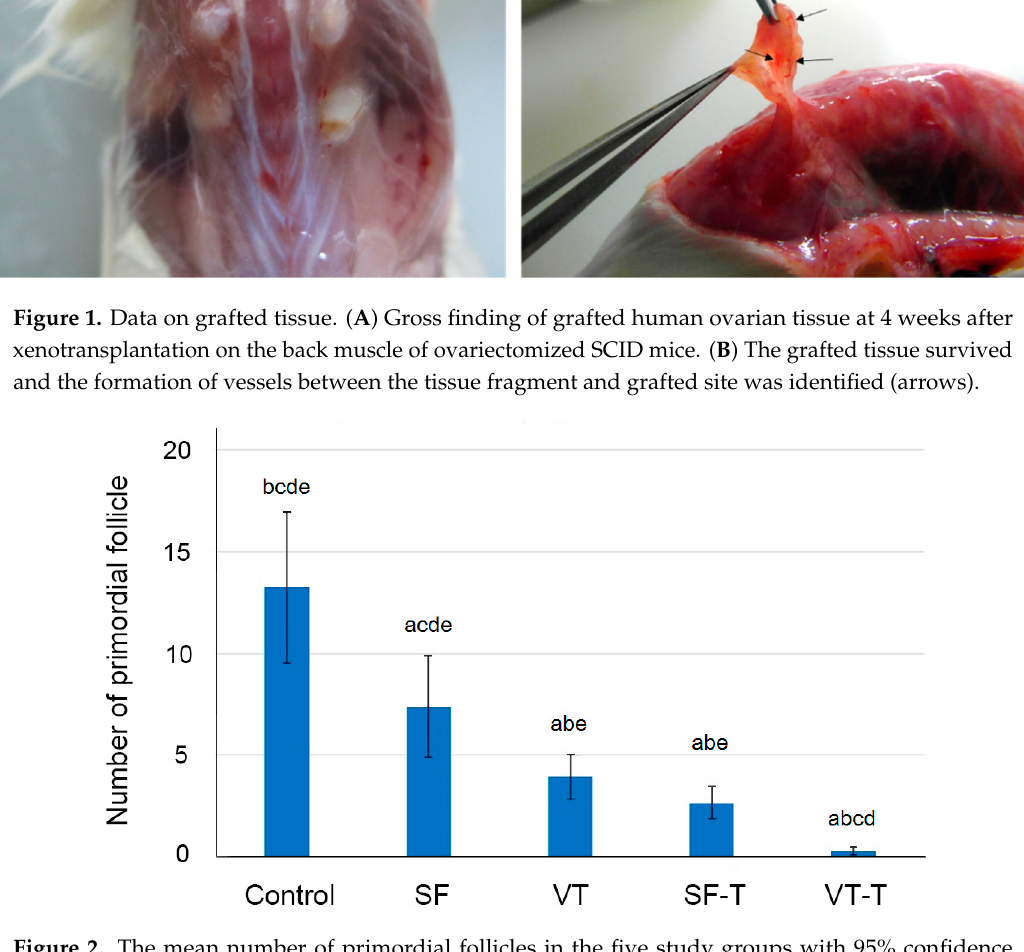
Figure 2. The mean number of primordial follicles in the five study groups with 95% confidence intervals. Student’s independent t -test showed that the mean number of follicular counts was significantly different among the different groups (letters above bars indicate the another groups statistically different from the one, P < 0.05): a, different from the control group; b, different from the SF group; c, different from the VT group; d, different from the SF-T group; e, different from the VT-T